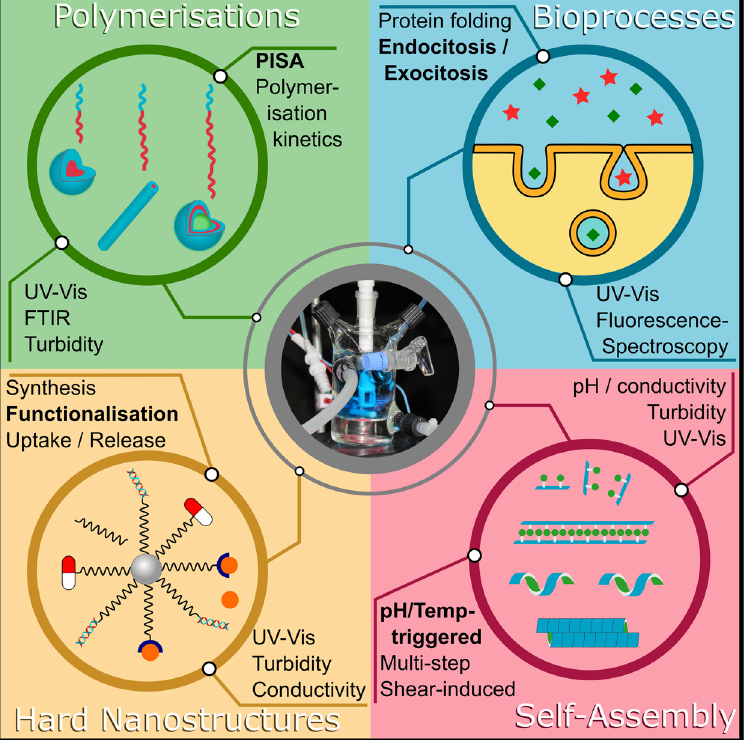
Figure 7. Illustrations of potential applications for an in-situ continuous-flow sample environment. The central photograph shows a prototype small-volume (25 mL), sealable, jacketed reaction vessel with turbidity probe, in operation on the D11